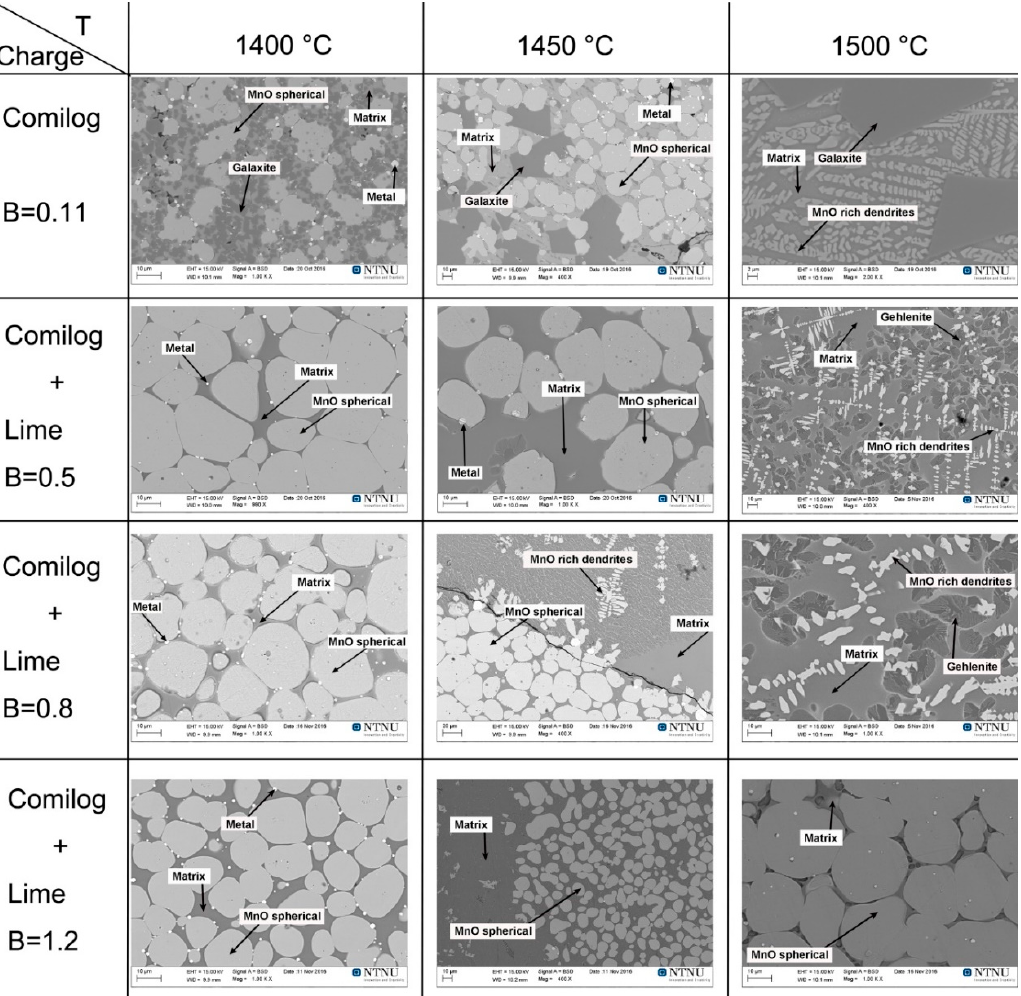
Figure 9. Electron backscatter images of Comilog charges with different basicities at different temperatures.